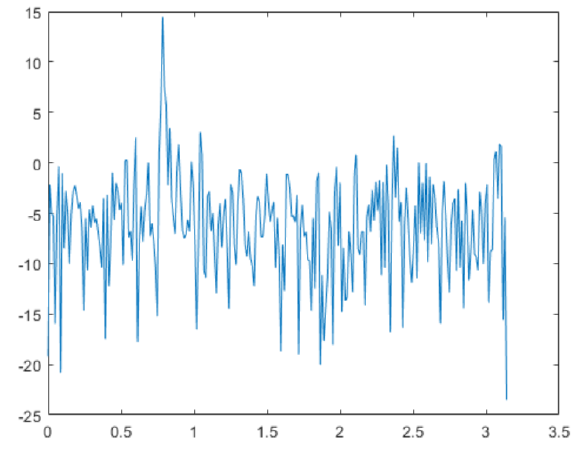
Fig. 5 Random sequence PSD. PSD, power spectral